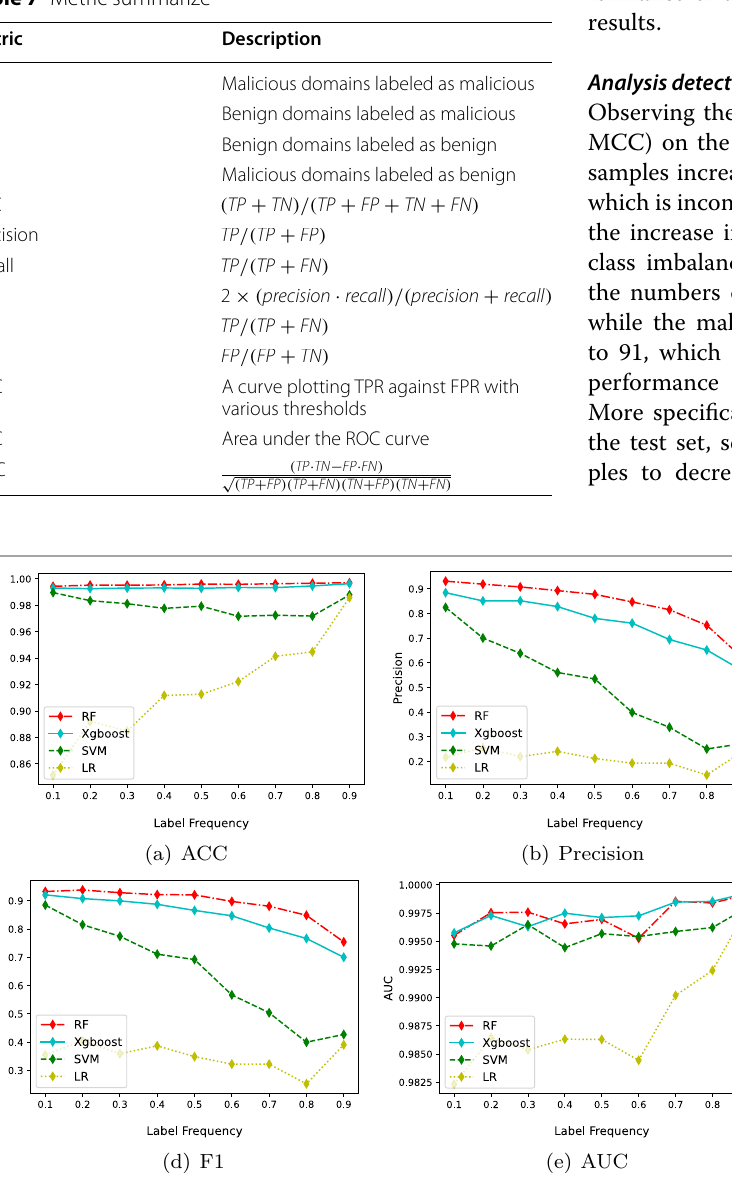
Fig. 5 Metrics evaluate score with different label frequencies. ( a ) Prediction ACC changes. ( b ) Prediction Precision changes. ( c ) Prediction Recall changes. ( d ) Prediction F1 changes. ( e ) Prediction AUC changes. ( f ) Prediction MCC